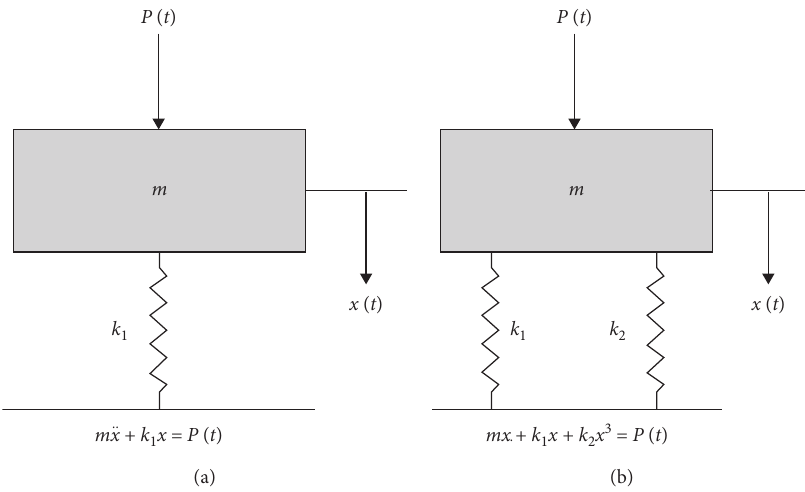
Figure 1: Governing differential equations for (a) linear and (b) nonlinear SDOF models.